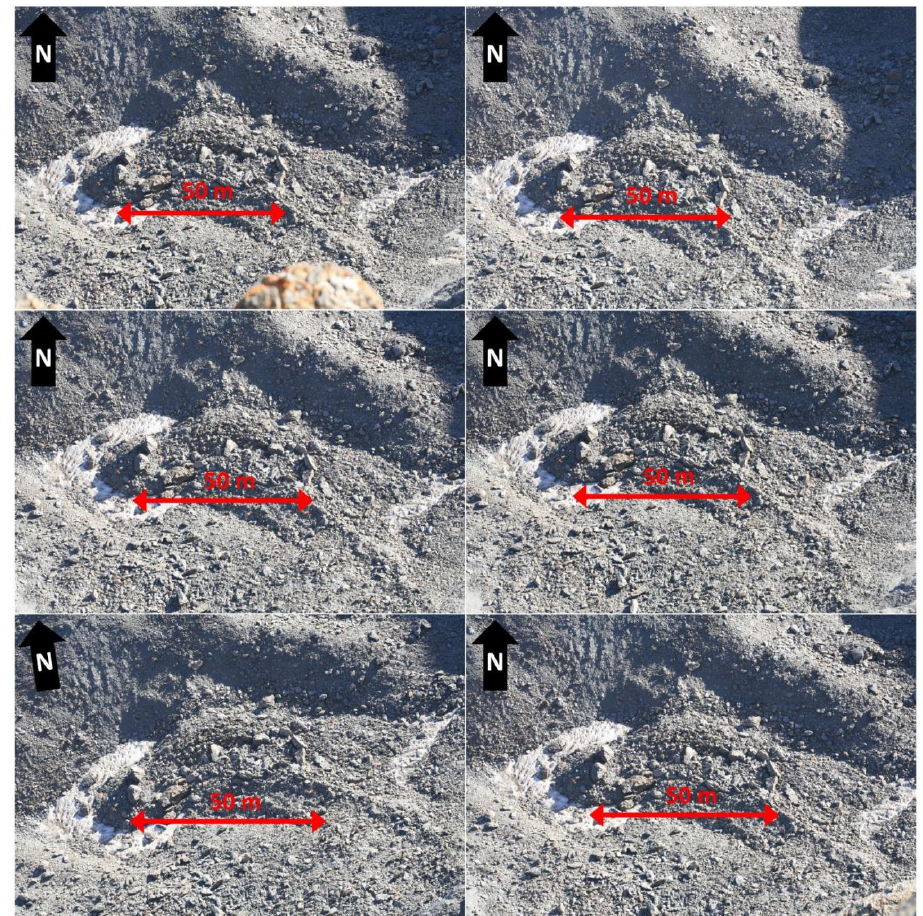
Figure 2. The images used as input in the photo-reconstruction